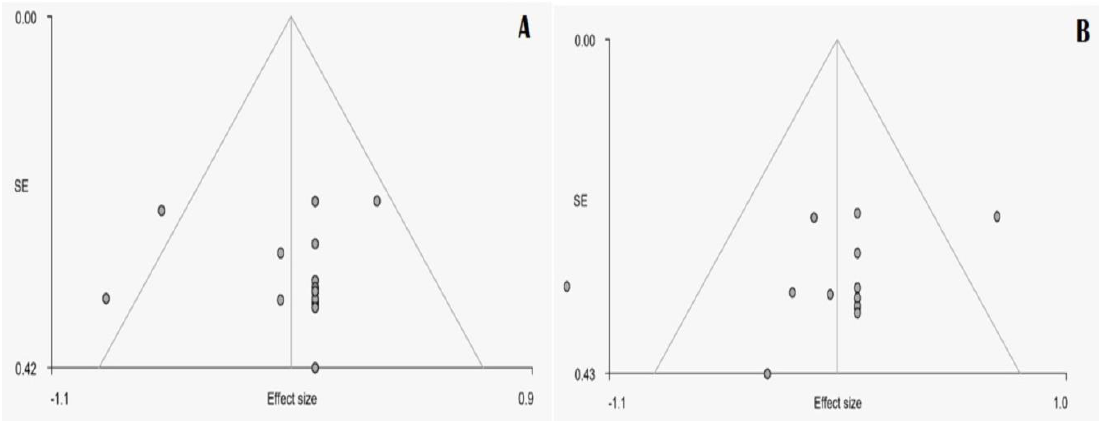
Figure 4. Funnel plots of the statistically significant results of the meta-analysis for the cerebellar vermis ( A ) and the cerebellar hemispheres ( B ). The horizontal axis represents effect sizes; the vertical axis represents the standard errors.